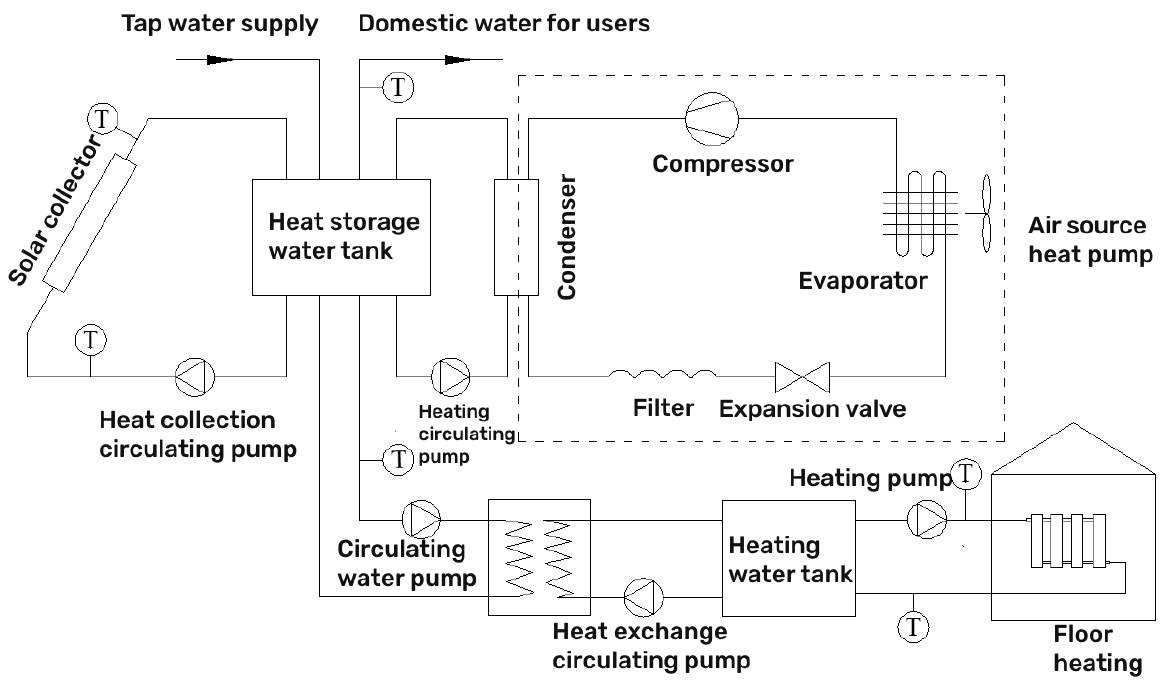
Figure 2. Schematic diagram of solar – air-source heat pump dual-supply heating system.